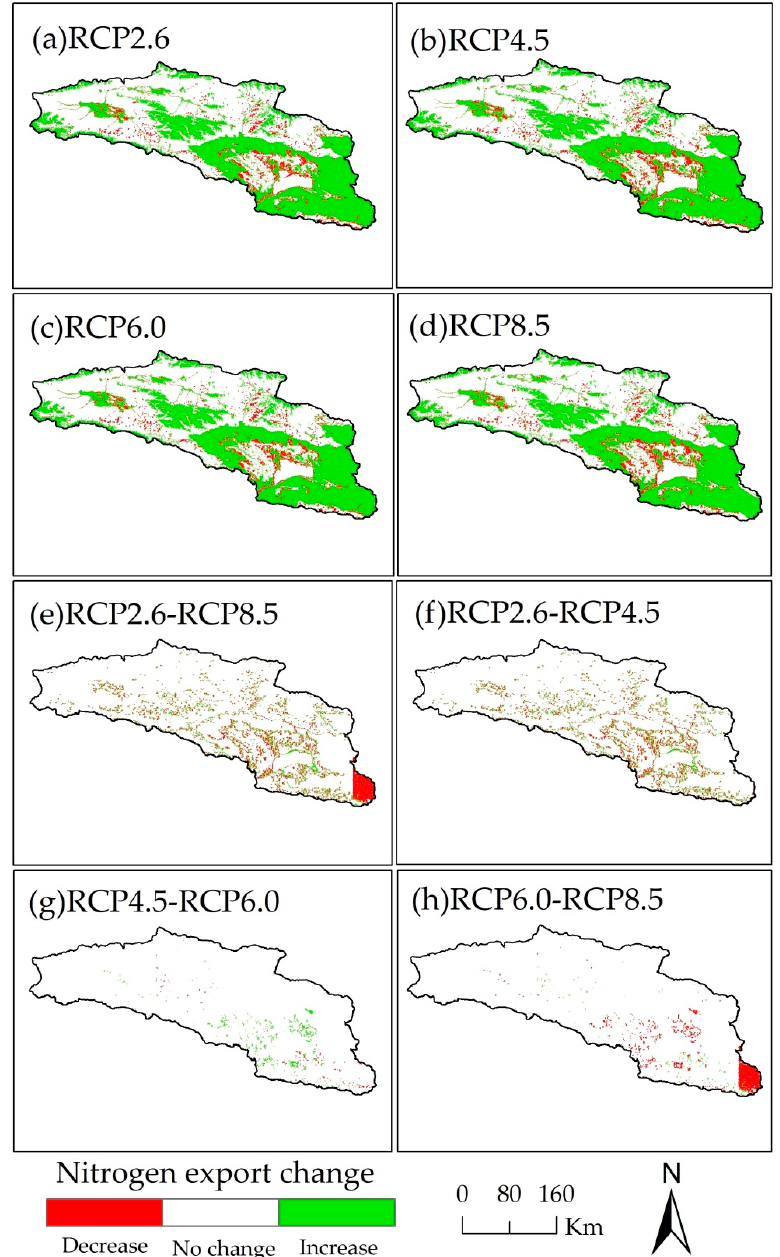
Figure 7. The spatial distribution of nitrogen export change of Bosten Lake basin in 2050 for RCP scenarios and in 2015 ( a – d ), between different RCP scenarios in 2050 ( e – h ).